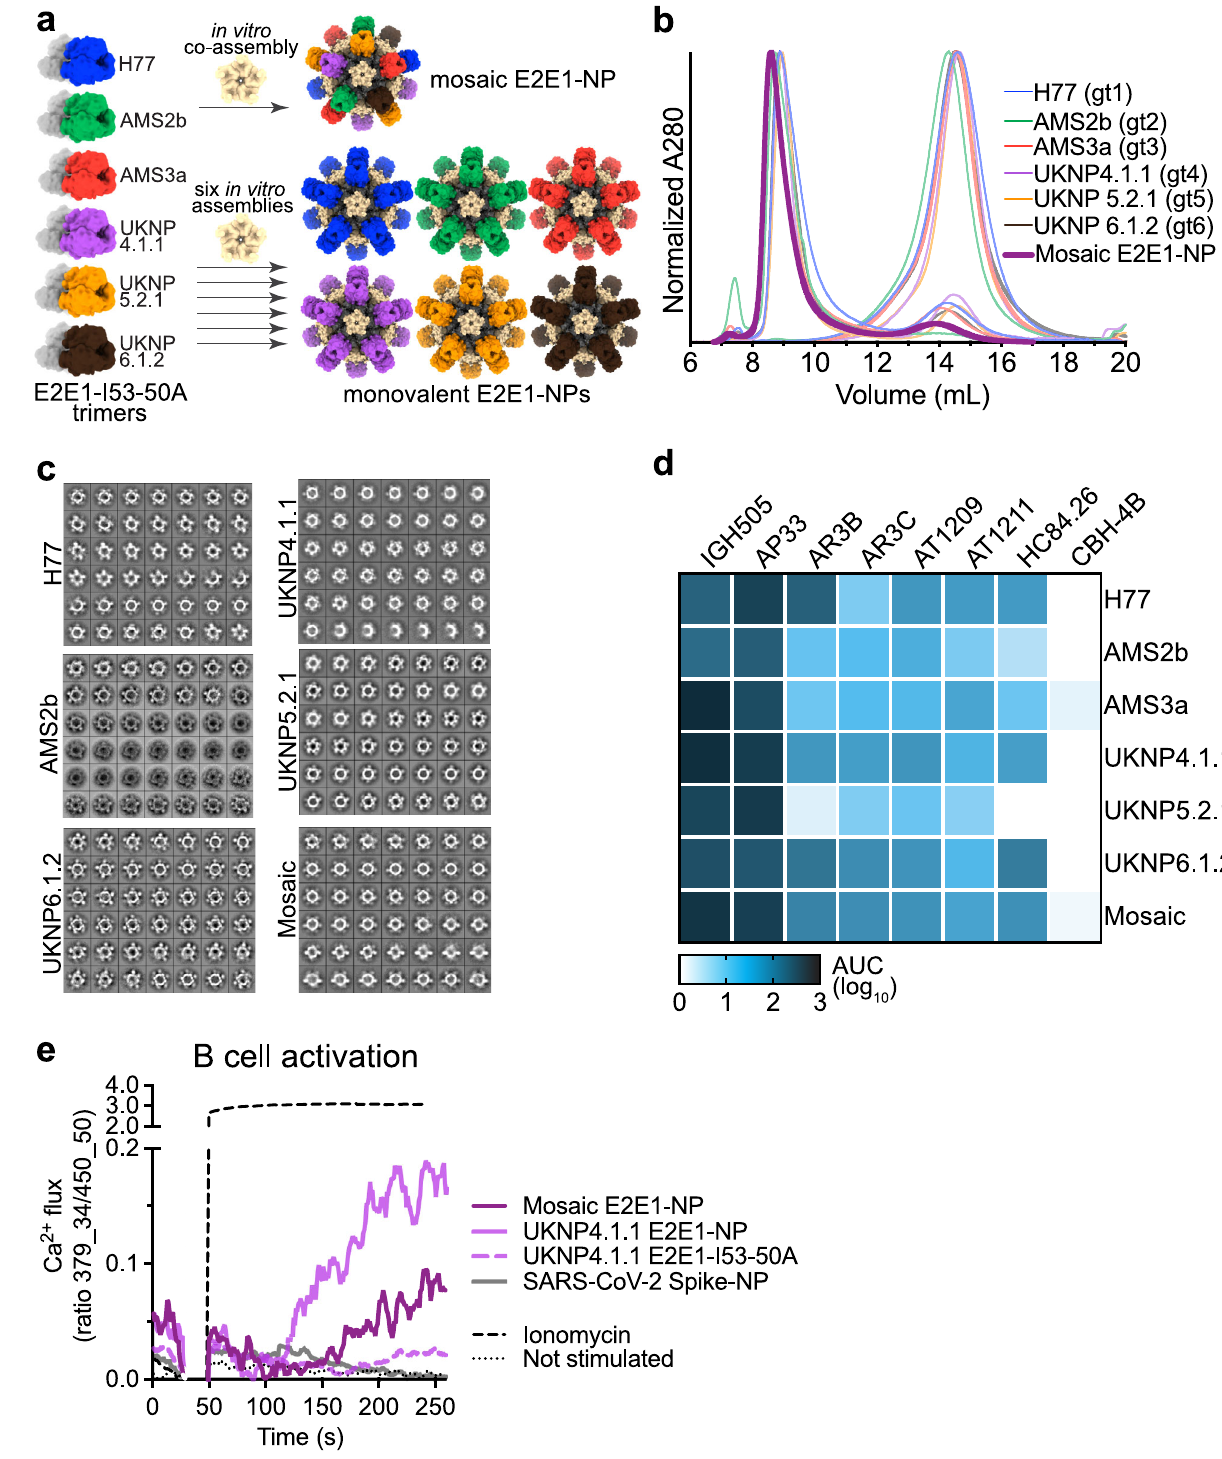
Fig. 4 | Generation of mosaic E2E1 nanoparticles. a Six E2E1-I53-50A trimers are combined and mixed with I53-50B pentamer to co-assemble as mosaic E2E1-NPs (top) or are individually mixed with I53-50B to assemble as monovalent E2E1-NP (bottom). b SEC pro fi les from a Superose 6 column of the mosaic E2E1-NP com- pared to six monovalent E2E1-NPs and the corresponding E2E1-I53-50A trimers. c NS-EM 2D class averages of mosaic and monovalent E2E1-NPs. d Binding of monovalent and mosaic E2E1-NPs to different mAbs measured by BLI. e B cell